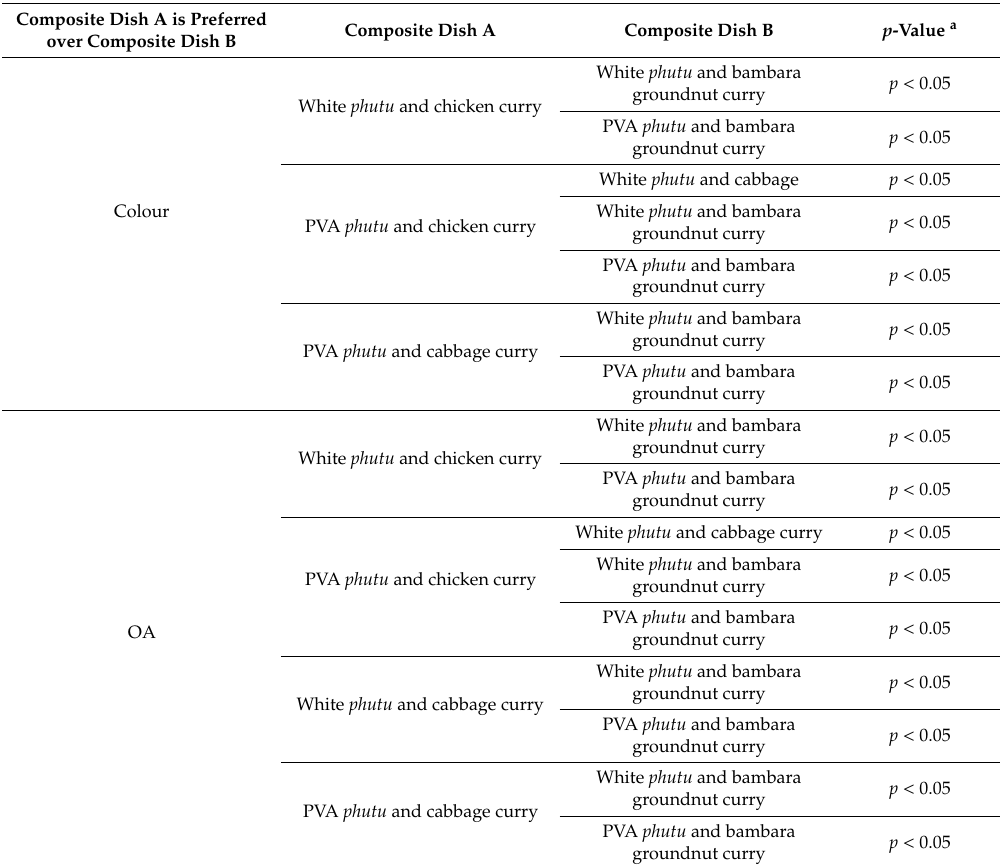
Table 8. Specific significant di ff erences between composite dishes and the sensory attributes of colour and overall